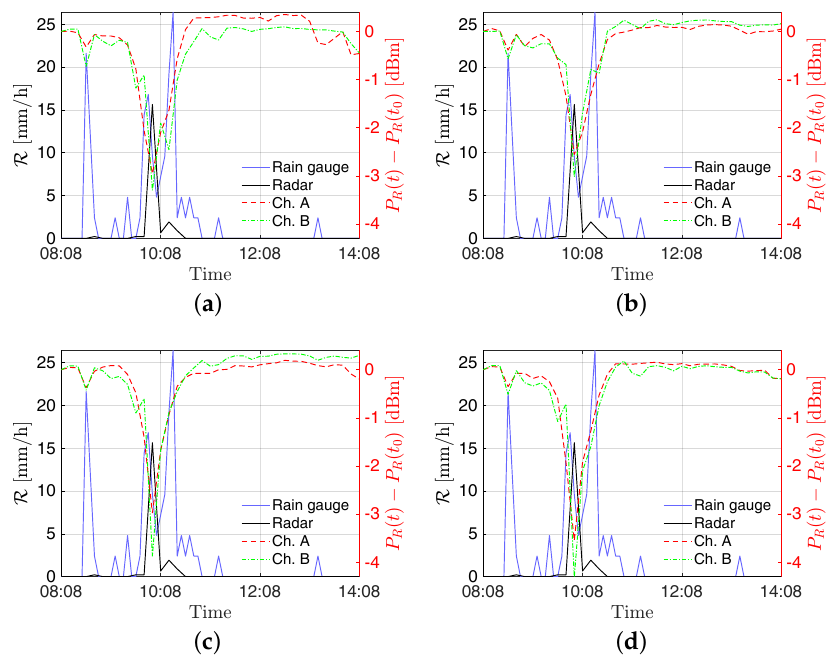
Figure 9. Received power variation [ dBm ] at the sites ( a ) S2 − Torcia, ( b ) PZS1, ( c ) Pala Eolica, and ( d ) Uffici Ingr on 14 August 2018. The signal power variations for channels A and B refer to the right y -axis, whereas the rain intensities R provided by the radar and the RG refer to the left y -axis.